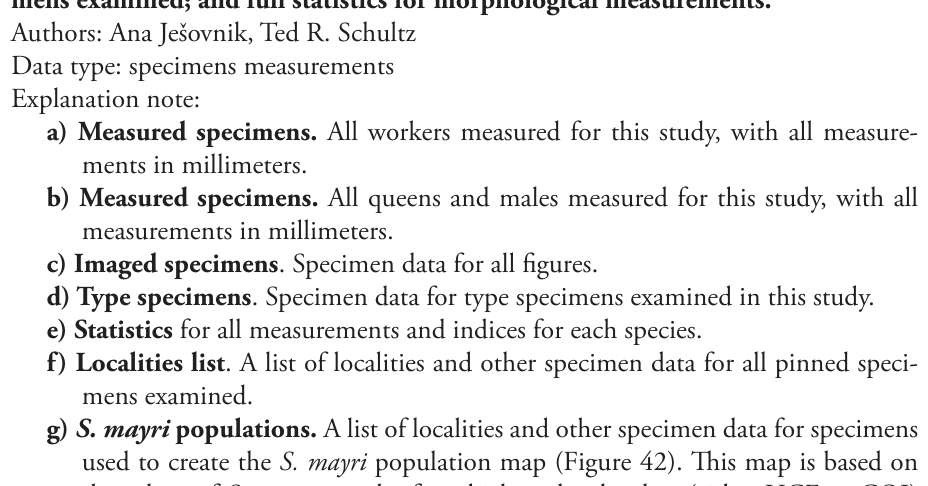
Table S2. Full list of measured, imaged, and type specimens; localities for all speci- mens examined; and full statistics for morphological